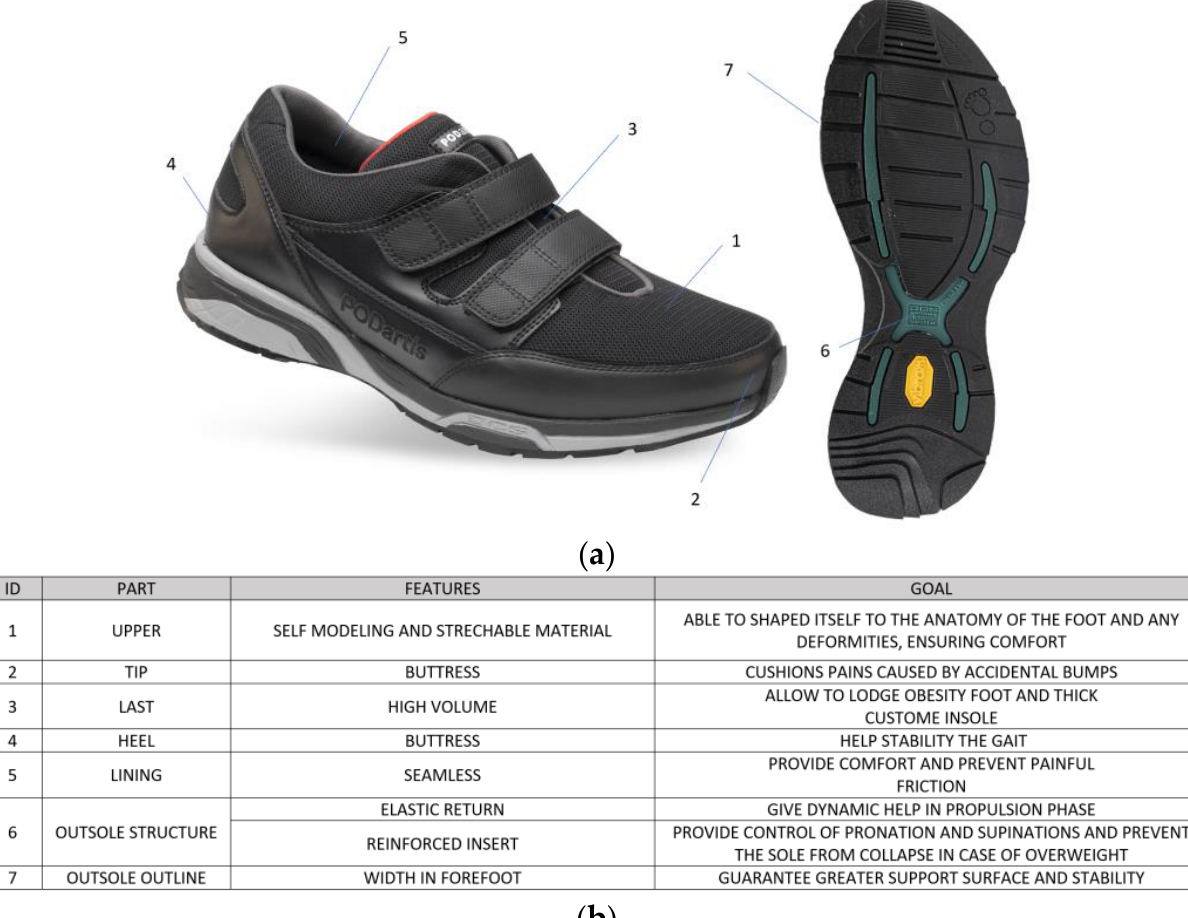
Figure 1. Image related to the obesity-specific shoes ( a ) and description of key elements of obesity- specific shoes with the role of each part ( b ).